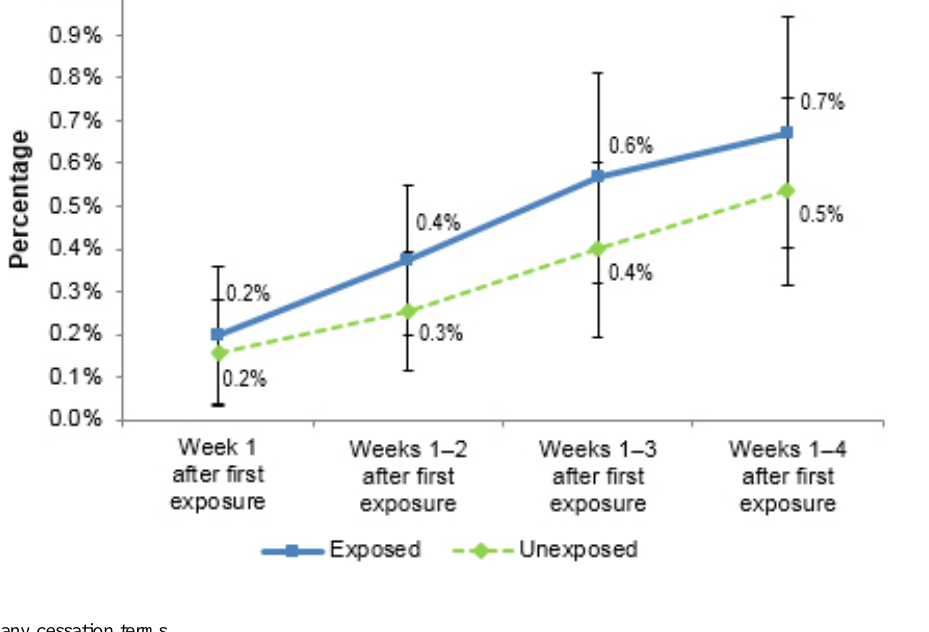
Table 5. Search for any cessation